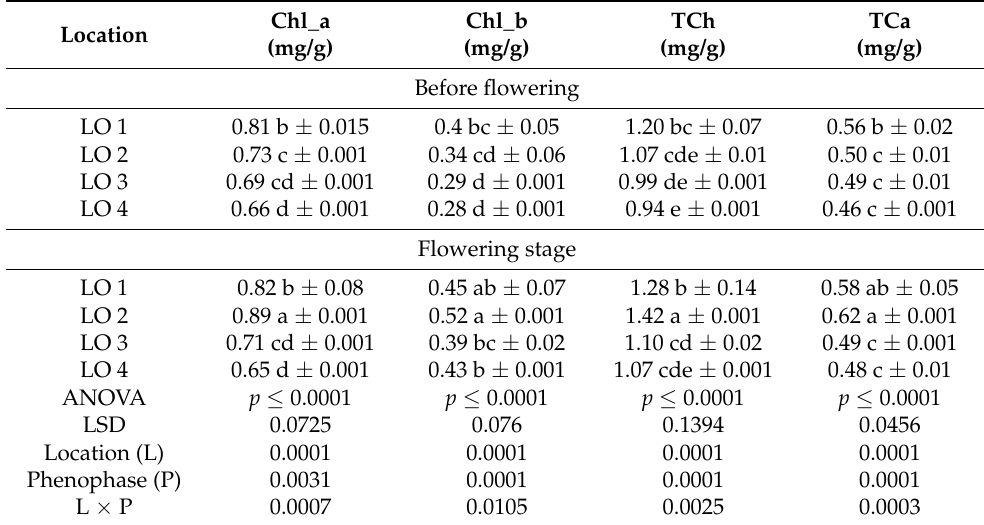
Table 5. Pigment compounds content of wild garlic leaves from different locations. Chl_a Location (mg/g)